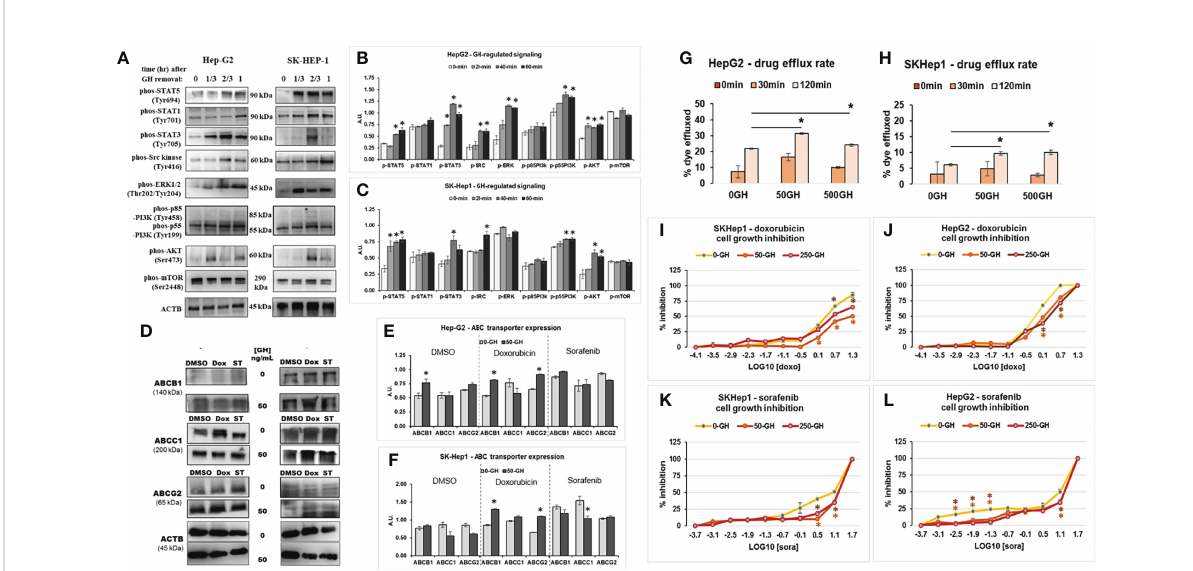
FIGURE 4 GH signaling drives drug resistance in human HCC cells. (A) Treatment with exogenous GH (50ng/mL) causes activation of STATs 3 and 5, SRC family kinase, ERK1/2 and PI3K-AKT signaling in human HCC cells - Hep-G2 (B) and SK-Hep-1 (C) cells in culture. (D) Doxorubicin or sorafenib tosylate (ST) and/or GH treatment increases ABCB1, ABCC1 and ABCG2 protein expression in human HCC cells – Hep-G2 (E) and SK-Hep-1 (F) in culture. (G, H) Recombinant human GH treatment (at 50 or 500ng/mL) increases drug ef fl ux rate in human HCC cells. (I – L) Recombinant hGH (at 50 or 250ng/mL) suppresses doxorubicin induced growth inhibition in SK-Hep-1 (I) and Hep-G2 cells (J) and sorafenib induced growth inhibition in SK-Hep1 (K) and Hep-G2 cells (L) . (*p < 0.05, Students t test, n =